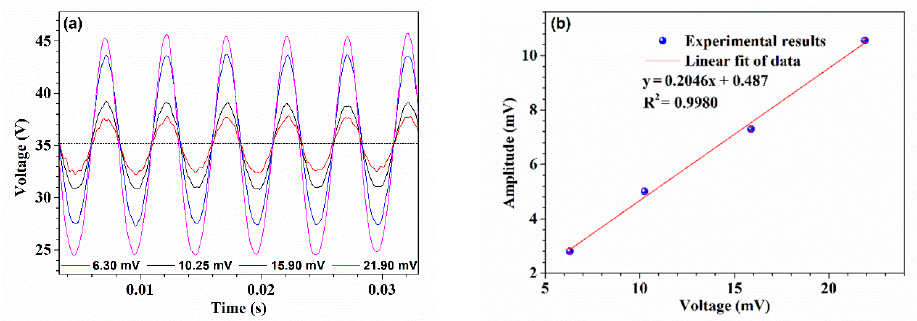
Figure 8. Response of the device based on HBF to vibrations amplitude. ( a ) Time-domain spectra of the output voltage, ( b ) Half peak–peak amplitudes of the output voltage at different driving voltages.